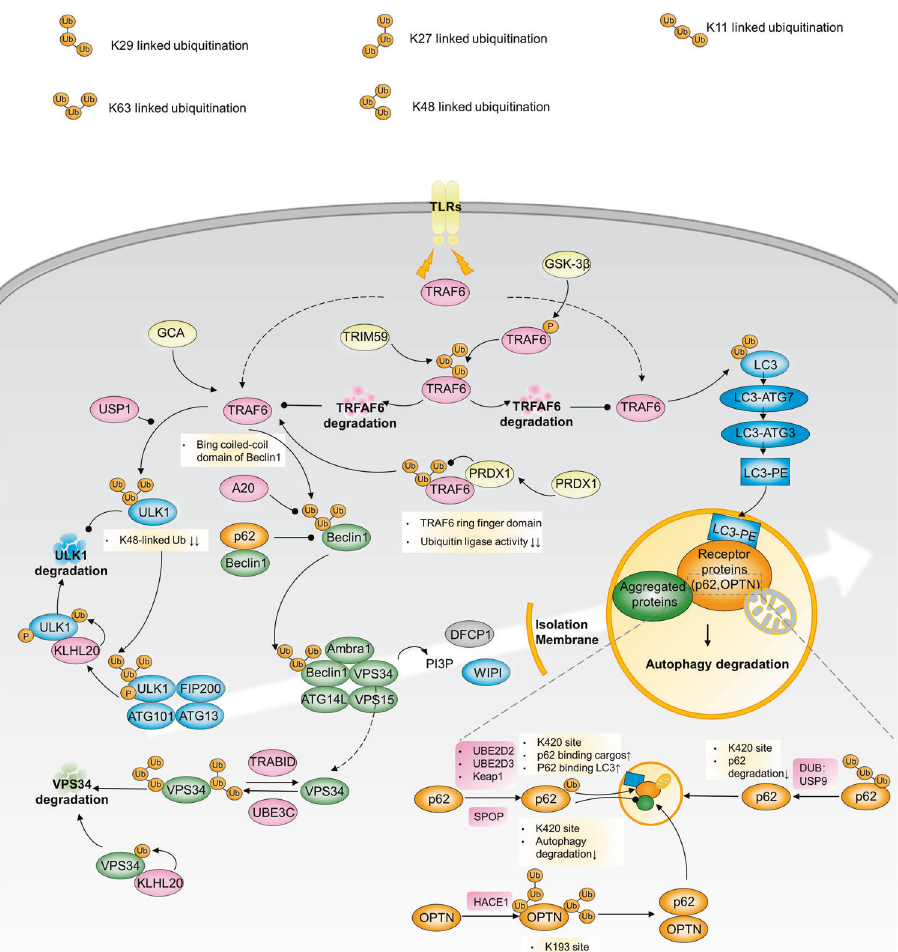
of K63-linked Beclin1 ubiquitination. PRDX1 binds to TRAF6 to inhibit K63-linked-ubiquitination of TRAF6, leading to reduced TRAF6 ubiquitin- ligase activity, which fails to activate Beclin1. KLHL20, UBE3C and TRABID reciprocally regulate K29/48-branched ubiquitination of